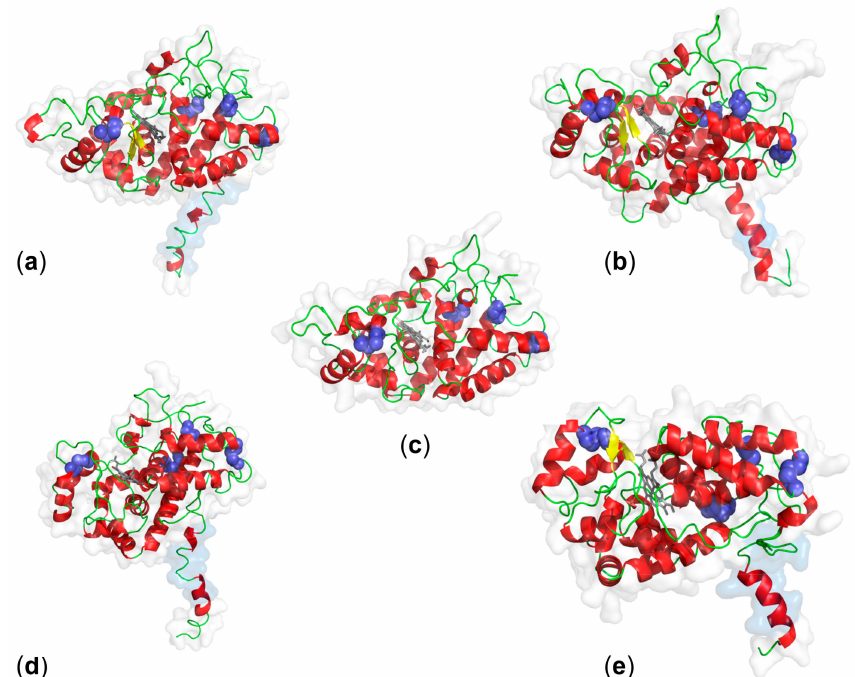
Figure 2. Putative tertiary structures of PM-bound class III peroxidases. Structures were predicted by SWISS-MODEL for ( a ) ZmPrx01 (3hdlA, 1 TMH, root PM), ( b ) OsPrx95 (3hdl1A, 3 TMH, root PM), ( c ) AtPrx64 (3hdl1A, 0 TMH, PM), ( d ) AtPrx47 (5twt, 1 TMH, PM), and ( e ) MtPrx02 (5twt1A, 1 TMH, root tip DRM). N-terminal amino acid sequences containing transmembrane domains (marine)